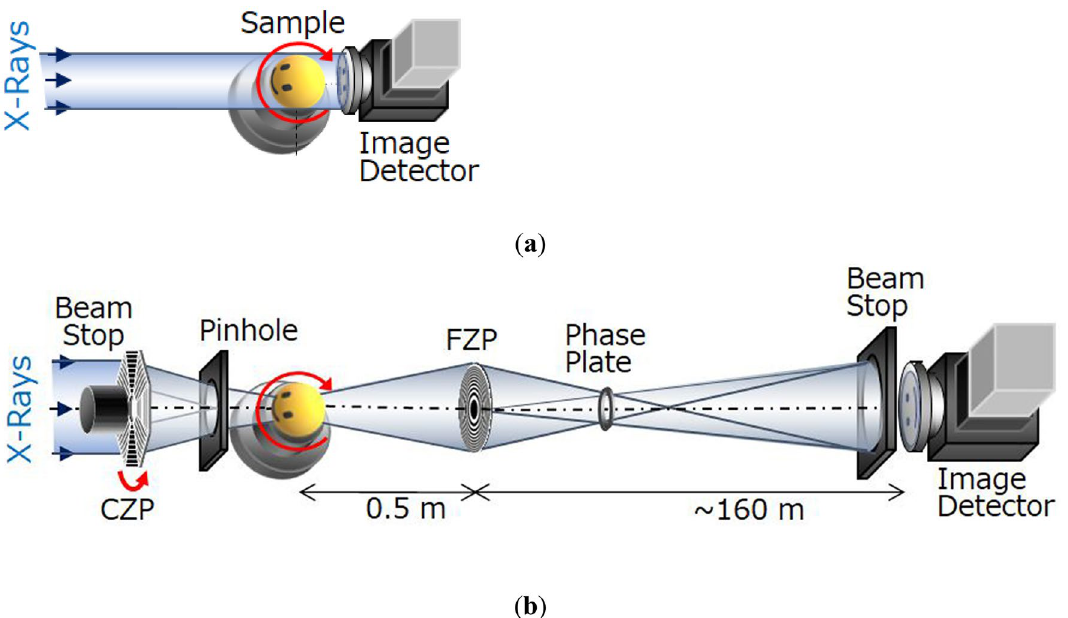
Figure 3. Schematics of ( a ) micro-CT and ( b ) nano-CT as synchrotron radiation multiscale X-ray CT available at beamline 20XU of SPring-8 32 . In micro-CT, a quasi-parallel beam transmitted through the rotating sample